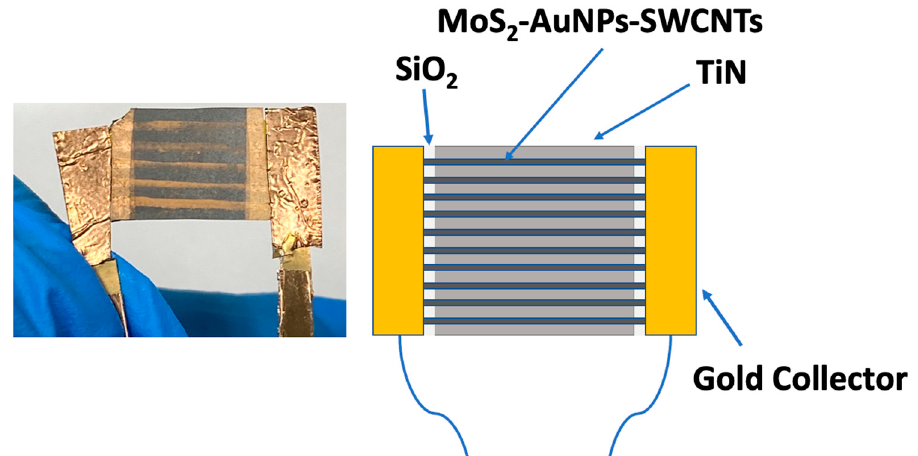
Figure 8. Picture of the device based on MoS 2 -Au@SWCNTs and schematic illustration of the di ff er- ent components.